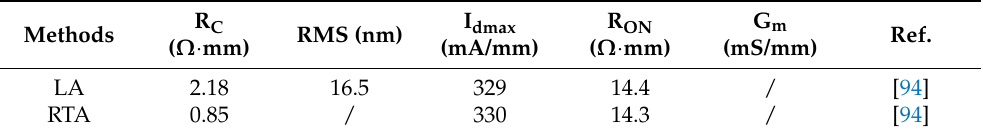
Table 6. GaN-based HEMTs devices’ electrical characteristics: LA vs. RTA.